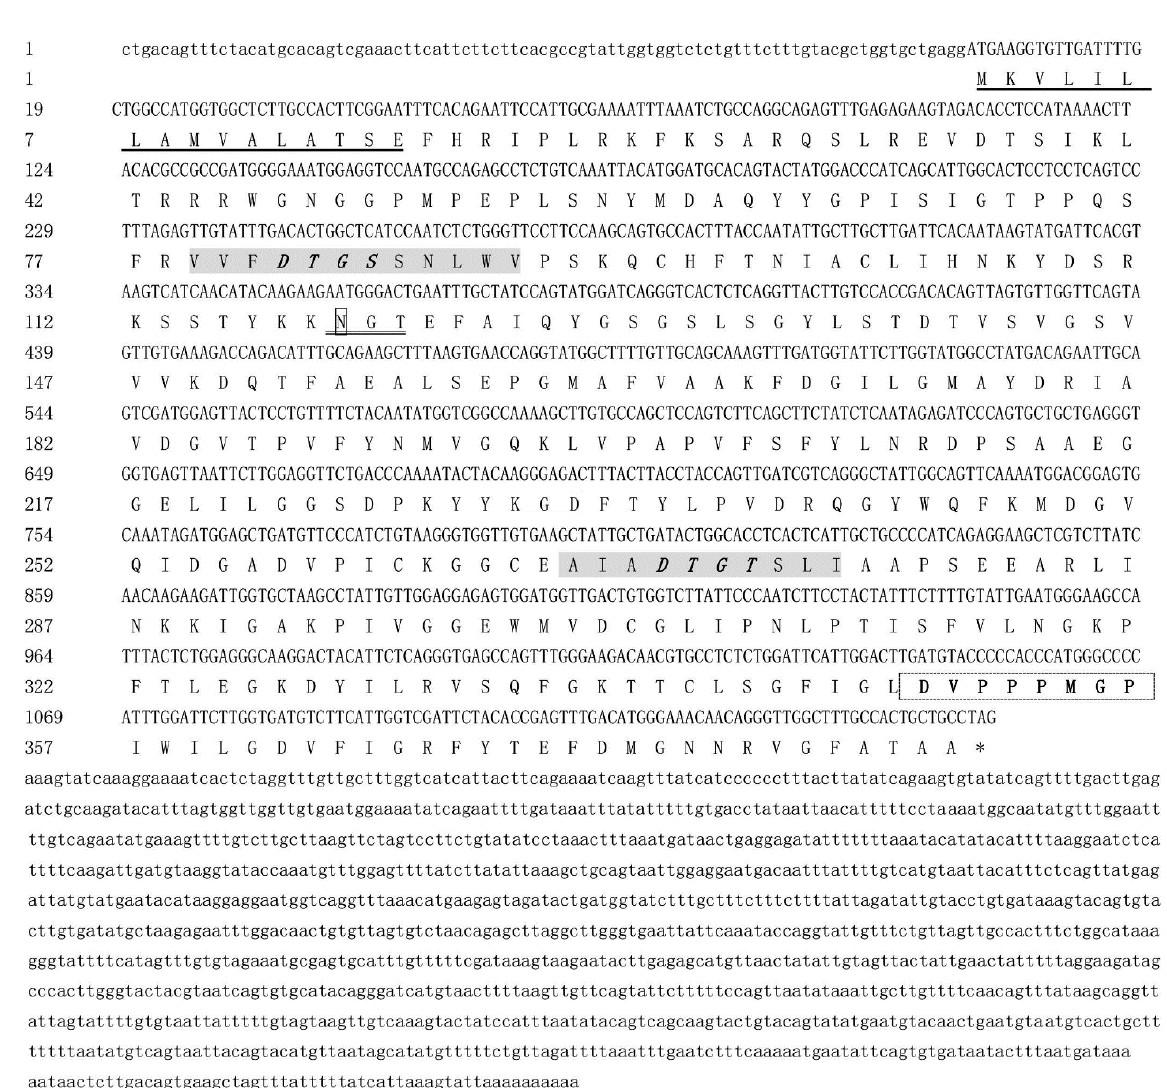
Figure 1. Full cDNA sequence and predicted amino acid sequence of Mn-CTSD. Signal peptides are represented by a solid underline; The N-glycosylation sites were in the square box of thick line. The two aspartic protease signature sequences were marked with gray shadows. The catalytic motifs (-DTGS-, -DTGT-) were in bold italics, and the enzyme activation sites were in bold and single underline. Non-digestive Mn-CTSD signature sequences are shown in bold with dotted boxes. Wavy line labeling is a tail signal.